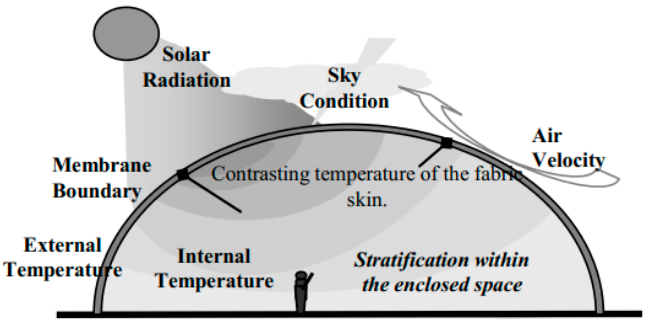
Figure 5. The influencing parameters for the overall performance assessment of textile membranes and fabric enclosures (reproduced from [52]).